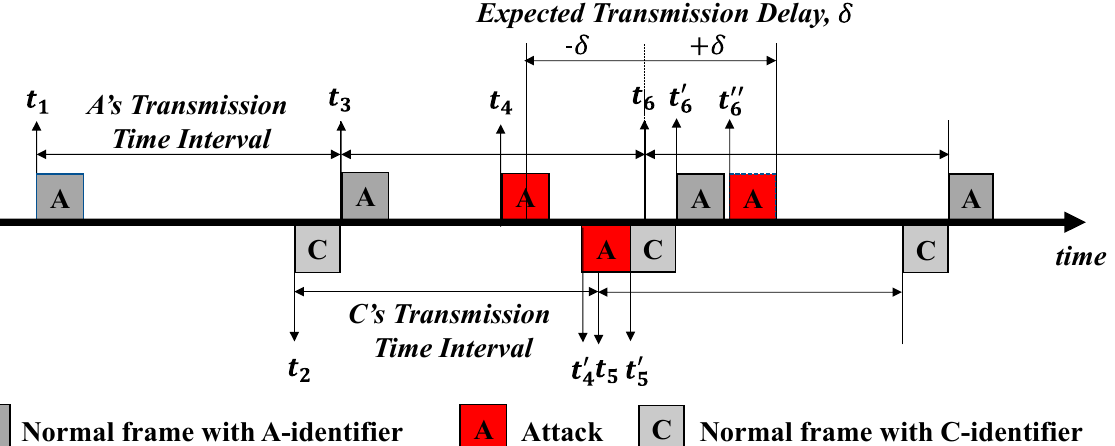
Figure 3. A transmission time interval-based cyber-attack detection method and the existing CAN’s problem.